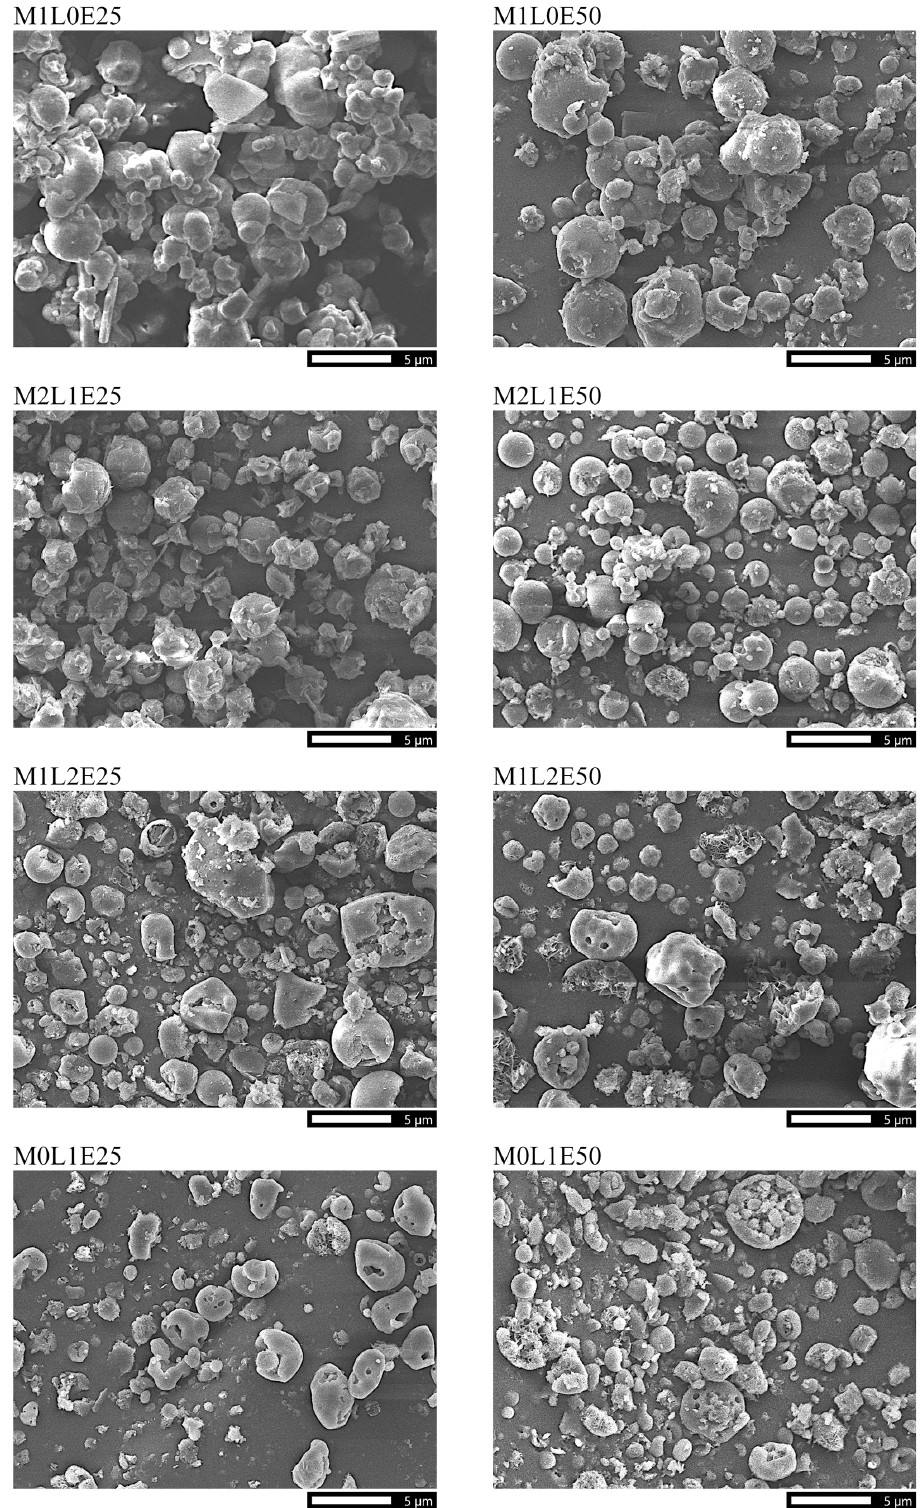
Figure 1. Scanning electron micrographs of the powder formulations. All micrographs were taken at the same magnification of 3 kX. The scale bar at the bottom of each micrograph represents a length of 5 μm.